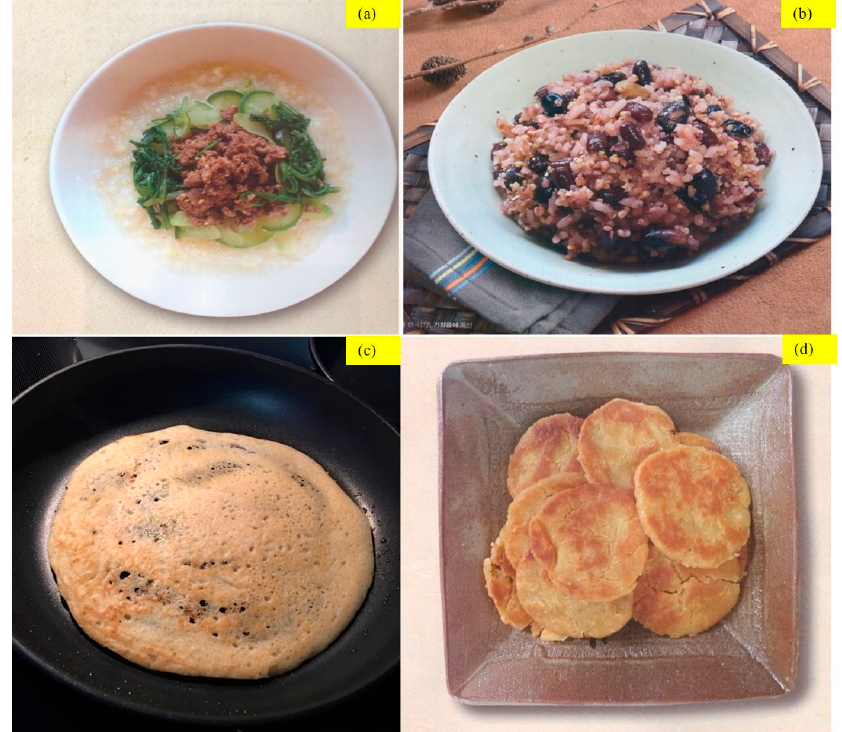
Figure 5. ( a ) A bowl of Jinju Noodles. ( b ) A platter of Ogokbap. ( c ) Millet Dosa—An Indian pancake made from fermented millet batter. ( d ) Noti—a Korean pancake made from waxy broomcorn millet flour. (Picture Credit; Dr. Hijin Kim and Dr. Cheol Ho Park for (a,b,d); Meenakshi Santra for (c)). Table 6. Glycemic index of the proso milled based products [66]. Percentage of Millet 100% 75% 25%